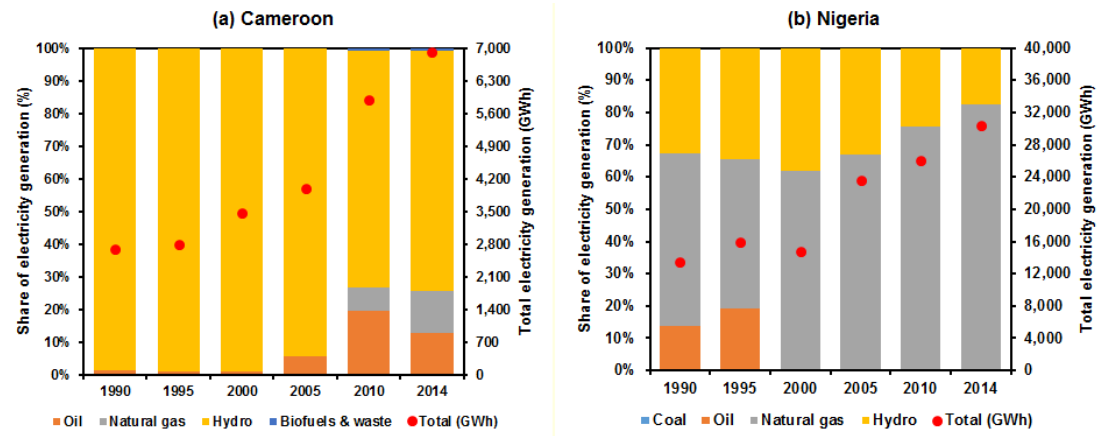
Figure 4. Total electricity generation (in GWh) for ( a ) Cameroon and ( b ) Nigeria in 2014. Adapted from [28]. Table 3. Electricity consumption (in GWh) in Nigeria from 1990–2014. Adapted from